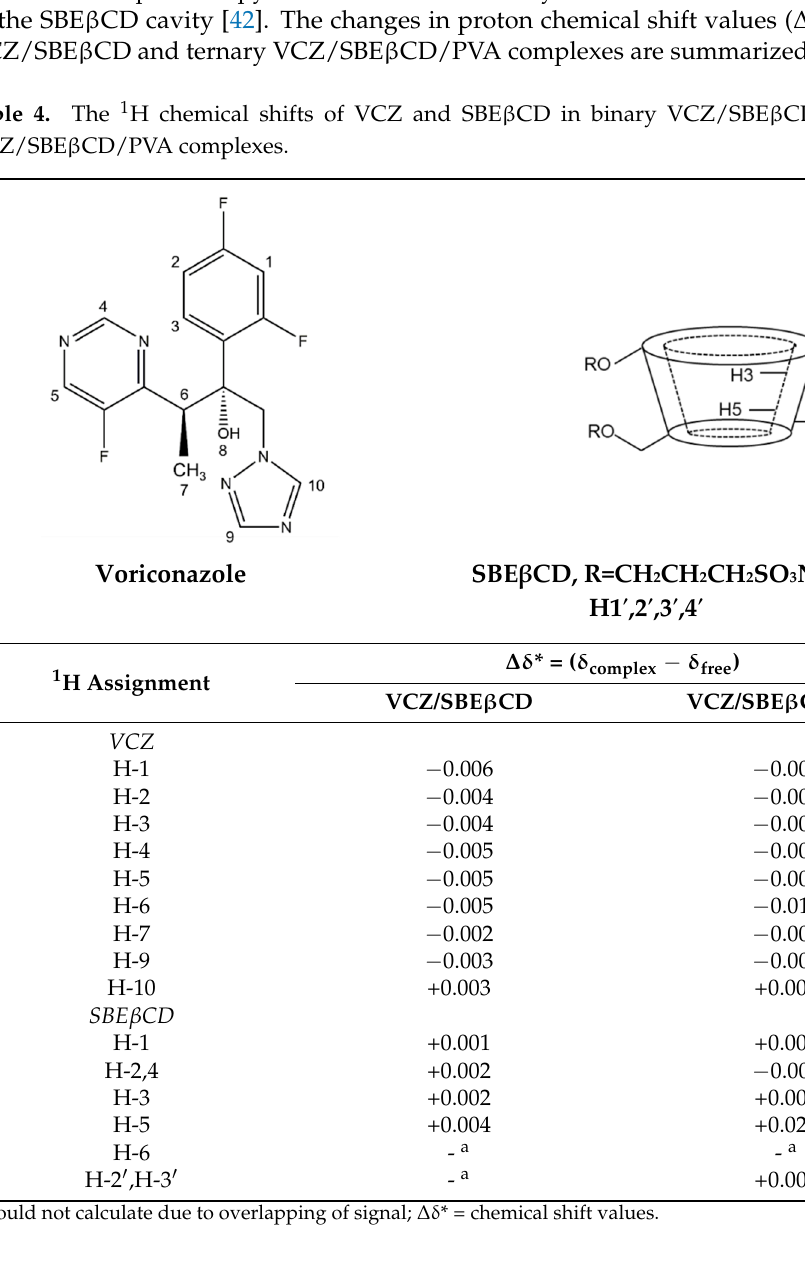
Figure 3. FT-IR spectra of ( a ) VCZ, ( b ) SBE β CD, ( c ) PM VCZ/SBE β CD, ( d ) FD VCZ/SBE β CD and ( e ) FD VCZ/SBE β CD/PVA.